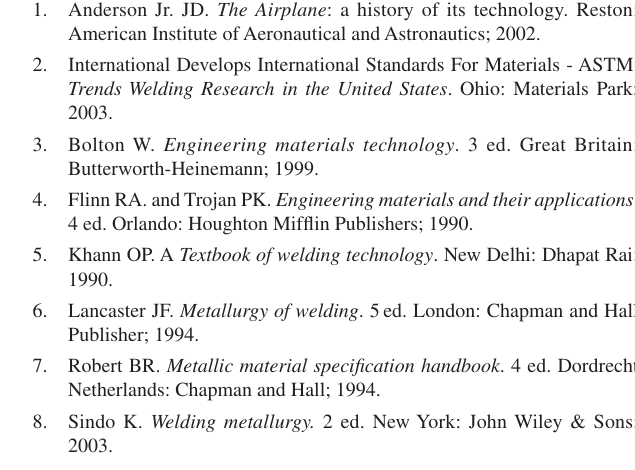
Figure 8. Micrograph of the control sample